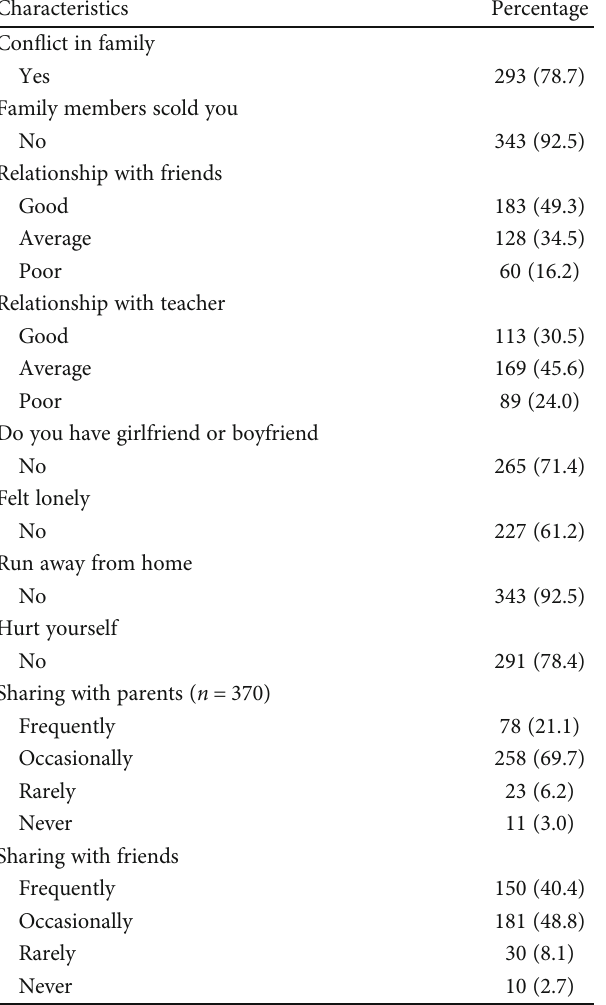
Table 5: Description of psychological factors of respondents ( n = 371 ).